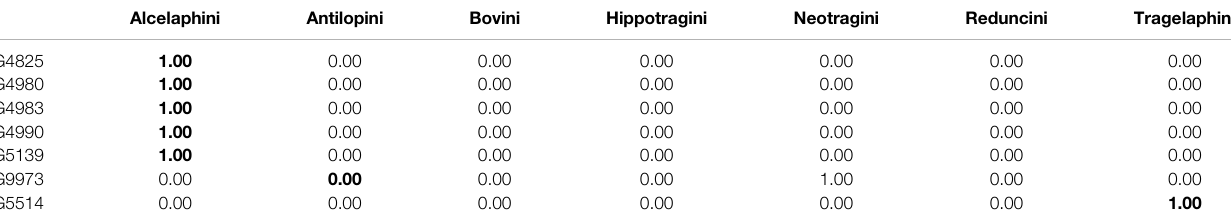
TABLE 2 | Real data . Tribe level predicted class probabilities from the knn classi fi er with k n (cid:2) 10. Emboldened values indicate the “ true ” class as obtained from an expert. Alcelaphini Antilopini Bovini Hippotragini Neotragini Reduncini Tragelaphini